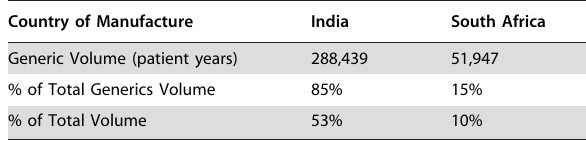
Table 4. Patent and Access Characteristics of First Line Antiretroviral Drugs in Sub-Saharan African Countries .. ... .... ... ... .... ... ... .... ... ... .... ... ... .... ... ... .... ... ... .... ... ... .... ... ... .... ... ... .... ... ... .... ... ... .... ... ... .... ... ... .... ... ... .